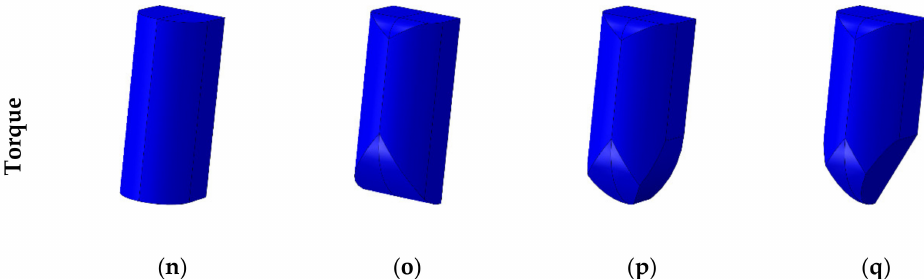
Figure 1. The various design of attachment for four orthodontic treatment situations. The shape of each attachment is defined as follows: ( a ) EX1; ( b ) EX2; ( c ) EX3; ( d ) EX4; and ( e ) EX5 for extrusion attachment; ( f ) IN1; ( g ) IN2; ( h ) IN3; ( i ) IN4; ( j ) IN5 for intrusion attachment; ( k ) RO1; ( l ) RO2; ( m ) RO3 for rotation attachment; ( n ) TO1; ( o ) TO2; ( p ) TO3; and ( q ) TO4 for torque attachment.